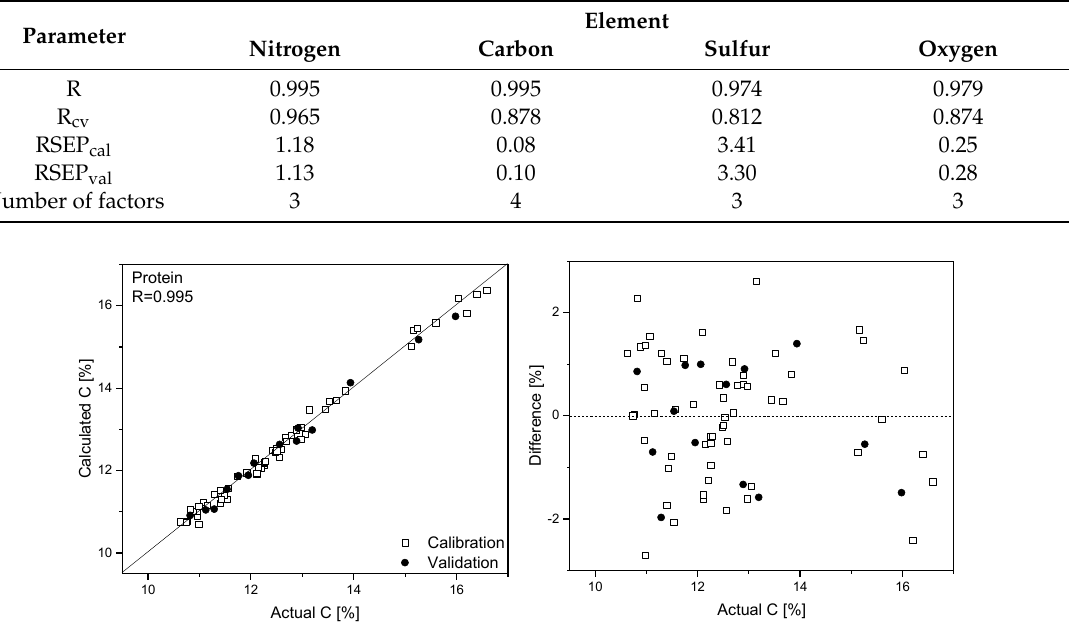
Table 2. Calibration parameters of the PLS models for N, C, S, and O quantification of in wheat flour.